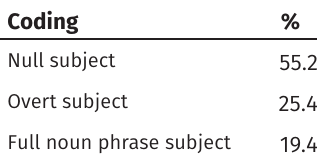
Table 8: General distribution of subject expression (N =